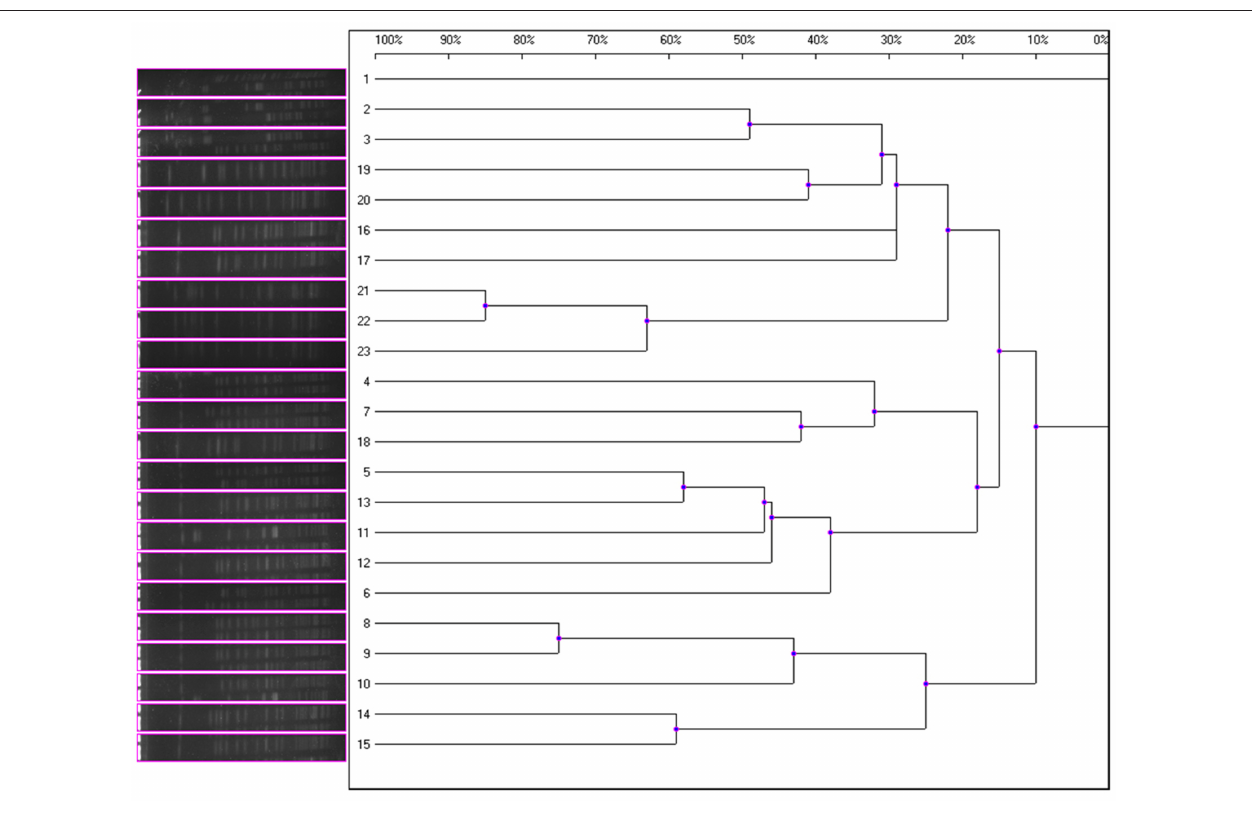
FIGURE 1 | Magnified dendrogram (representation of hierarchical cluster analysis) of 23 K1hvKP isolates.